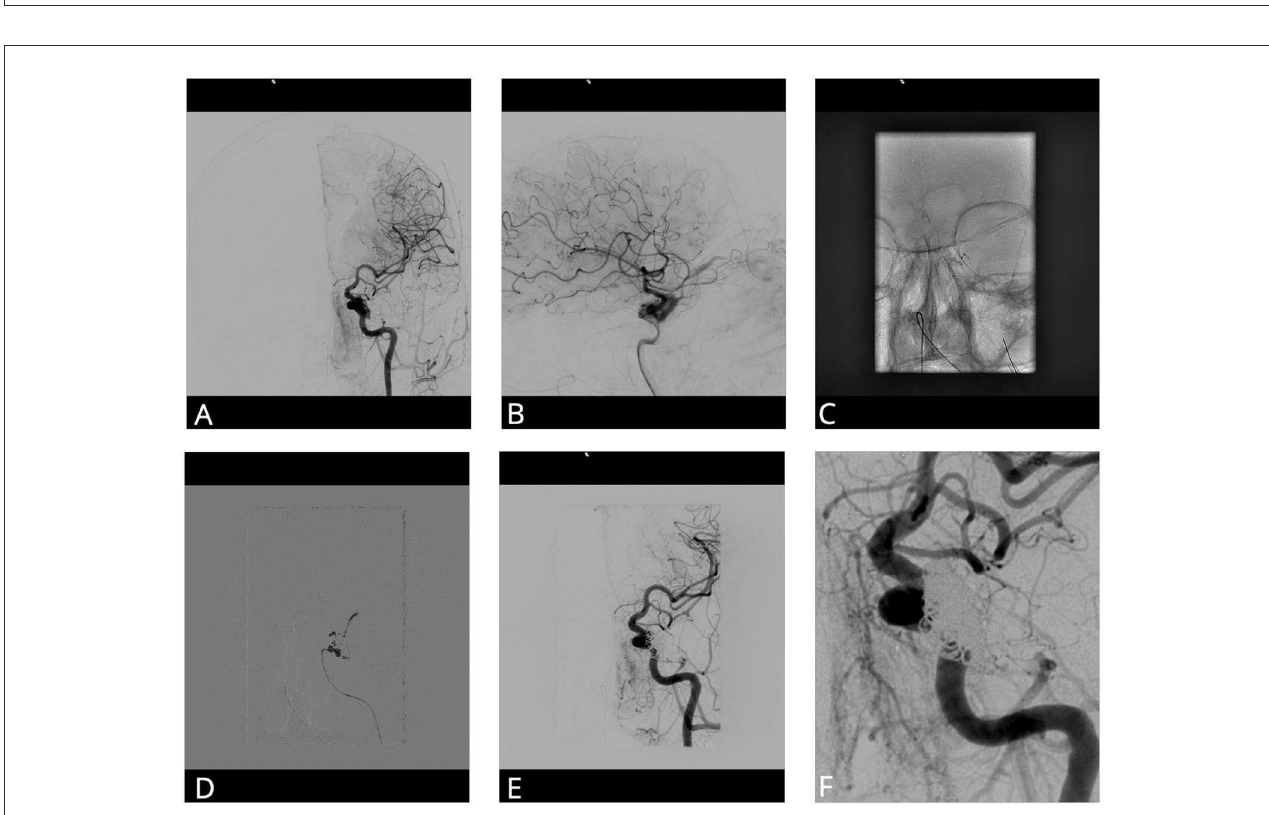
FIGURE2 Cranial angiogram of a patient with progressive headache and visual deficits. (A, B) Anteroposterior and lateral DCA image after injection of the left ICA shows a CCF with origin of the lateral wall of the cavernous part of the ICA. (C) Two microcatheters in the cavernous sinus via a transvenous route. (D) Application of 0.44ml of Onyx after filling the cavernous sinus with some coils. (E, F) Control anteroposterior angiogram shows complete fistula occlusion. CCF, Carotid cavernous fistula; DCA, Diagnostic cranial angiography; ICA, Internal carotid artery.